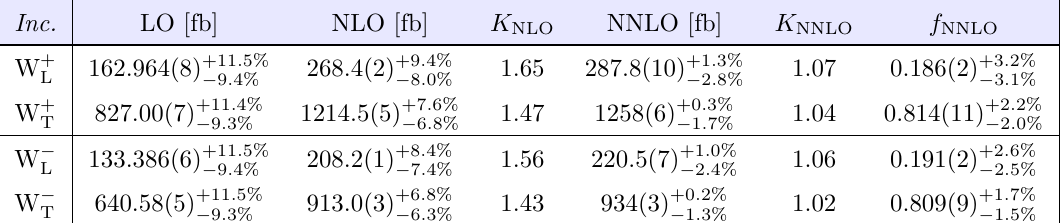
Table 1 . Total cross sections of pp → ‘ ± ( − ) ν ‘ j for the inclusive setup at the LHC with the centre- √ of-mass energy of s = 13 TeV. The polarised predictions are provided at LO, NLO, and NNLO accuracy along with the corresponding K -factors. The last column represents polarisation fractions at NNLO, calculated as a ratio of the polarised result to the sum of the two polarisations. The numbers in parentheses indicate statistical errors in the last significant digit, while sub- and super- scripts represent scale variation uncertainty with respect to the full result.